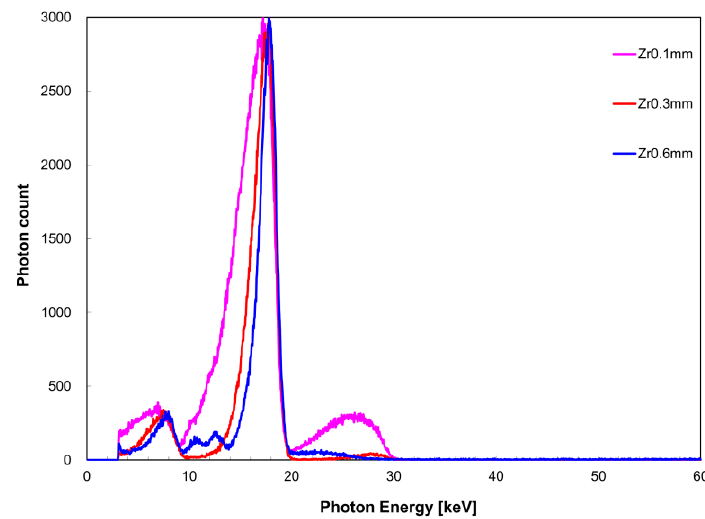
Figure 4. Filter thickness dependence of X-ray spectrum when the zirconium filter was used.